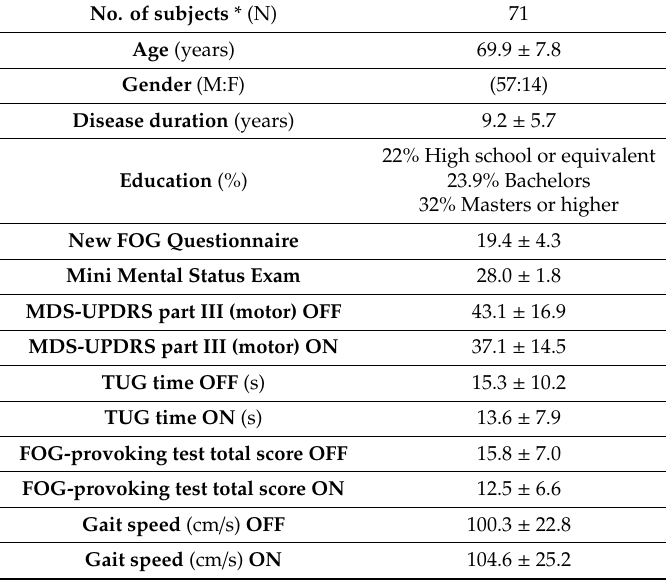
Table 2. Subject